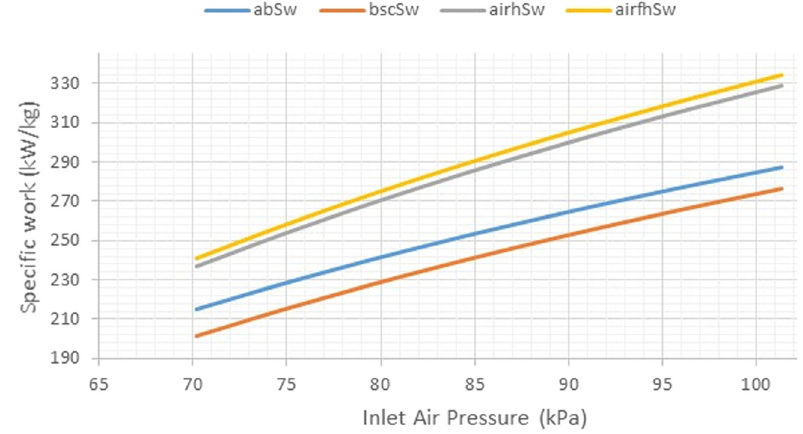
Figure 6: Variation of the speci fi c work with inlet air ( atmospheric ) pressure for ab, bsc, airh, and airfh cogeneration systems.